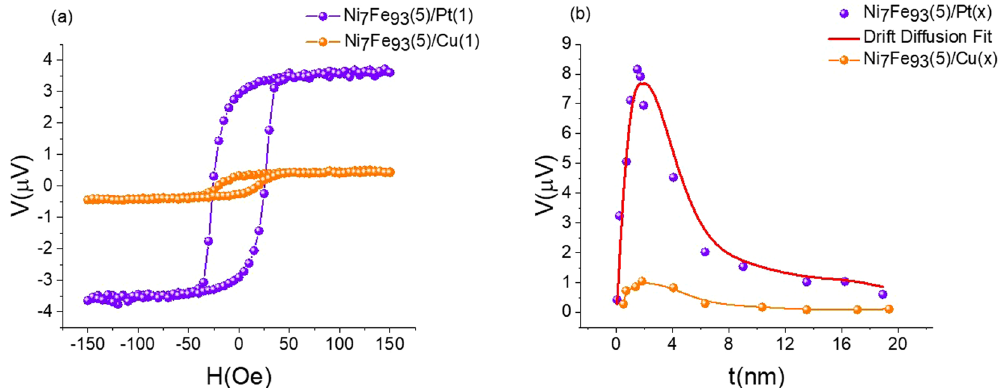
Figure 3. ( a ) The thermal voltage measured for Ni 7 Fe 93 (5)/Pt(1) and control sample Ni 7 Fe 93 (5)/Cu(1). Films are heated under the same heater power as in Fig. 2. Signal for sample with Pt is more than 20 times larger than that for Cu. ( b ) The thickness dependence of the thermal voltage. Curve for Ni 7 Fe 93 (5)/Pt(x) peaked when Pt thickness is about 2 nm. The parameters for the fitting are: λ = . nm 1 3 Pt Curve for Ni 7 Fe 93 (5)/Cu(x) does not show any significant variation with the thickness of Cu except a little bump around 2